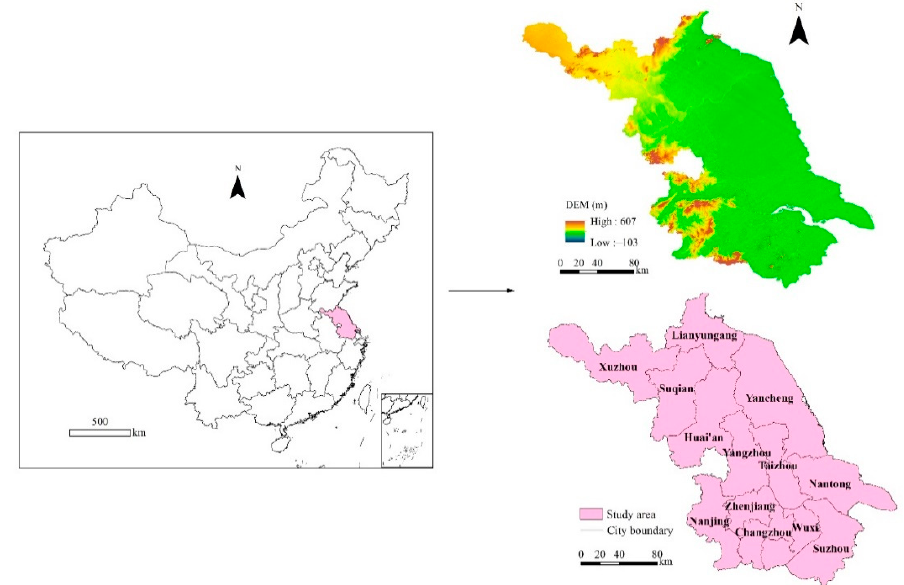
Figure 1. Location of the study area. Digital elevation model (DEM) is a digital simulation of ground by elevation data.